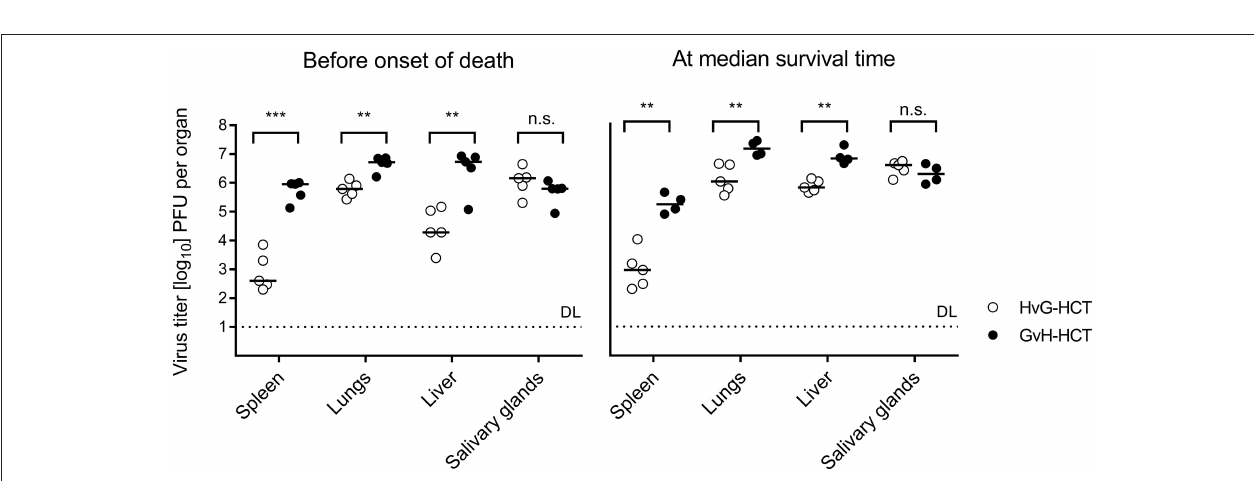
FIGURE 2 | Bone marrow repopulation is not affected by MHC class-I mismatch or mCMV infection. HCT donors were of male sex for tracking the fate of transplanted hematopoietic cells (HC) by qPCR specific for the Y-chromosomal gene sry . Donor HC and progeny thereof were quantitated in the tibial bone marrow cell population. Total cell numbers were determined by pthrp-specific qPCR. Symbols indicate mice analysed individually. Note that for comparison of all four HCT groups (recall Figure 1A ) data in the lower left panel were reproduced from own previous work on HvG-HCT (Seckert et al., 2011).